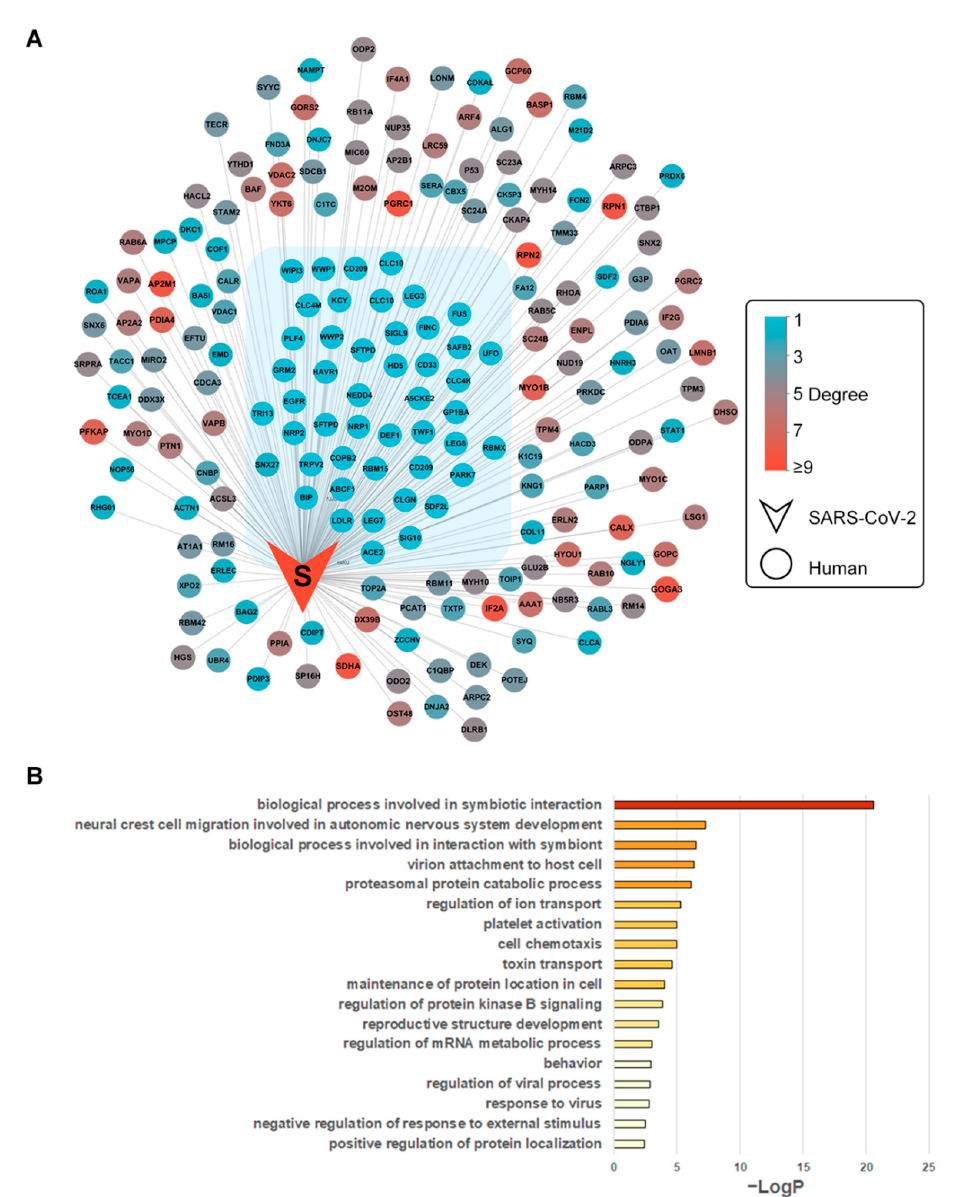
Figure 2. Integrated SARS-CoV-2–human PPI S protein subnetwork and functional enrichment. ( A ) The subnetwork of S protein with its 196 first neighbors. The isolated interactions (degree = 1) were grouped in blue shadow; ( B ) GO enrichment of S protein’s isolated interactions. Nodes represent viral (V-shape) or human (ellipse-shape) proteins. Edges represent protein–protein interactions. The nodes are colored according to their degrees. For human proteins, the degree values range from 1 to 9 (from light blue to red shade). Nodes with lower degree values have fewer physical associations or direct interactions with other SARS-CoV-2 proteins.